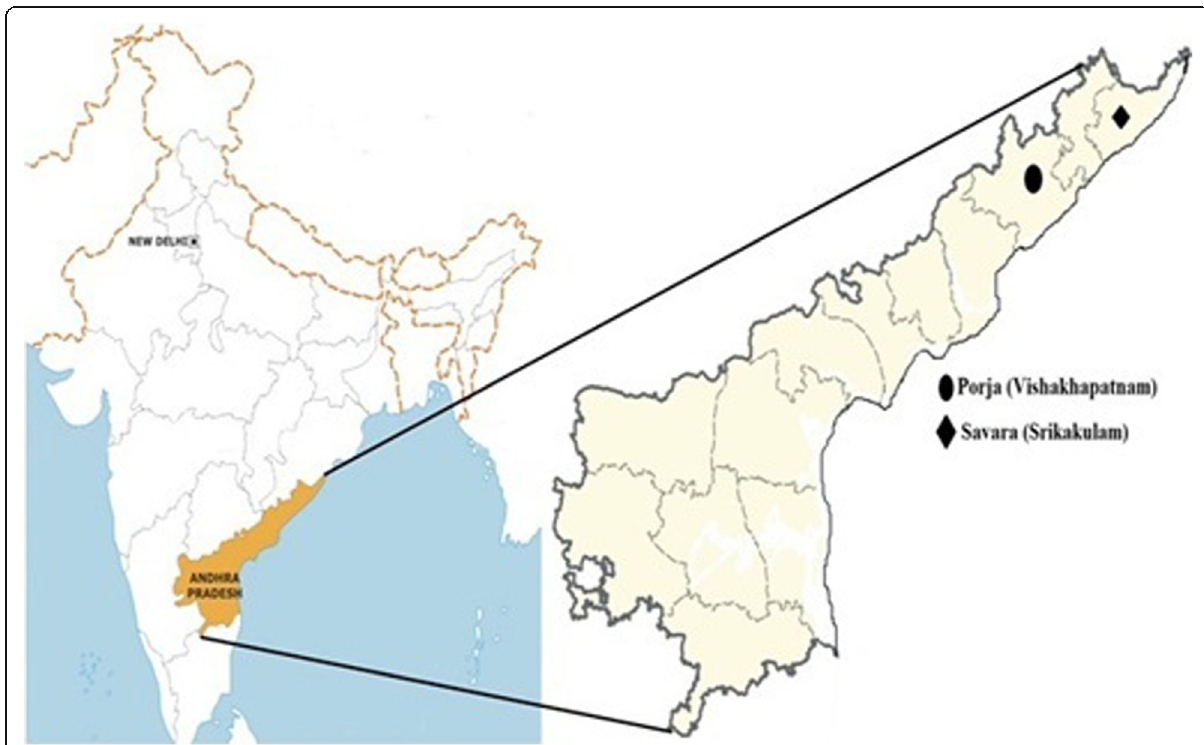
Fig. 1 Map of India highlighting Andhra Pradesh (left); sample collection area (right)